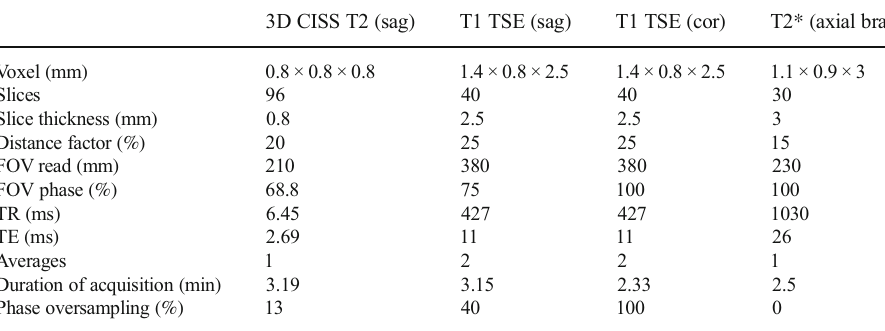
Table 1 Sequence parameters for postmortem fetal magnetic resonance imaging (PMFMRI)